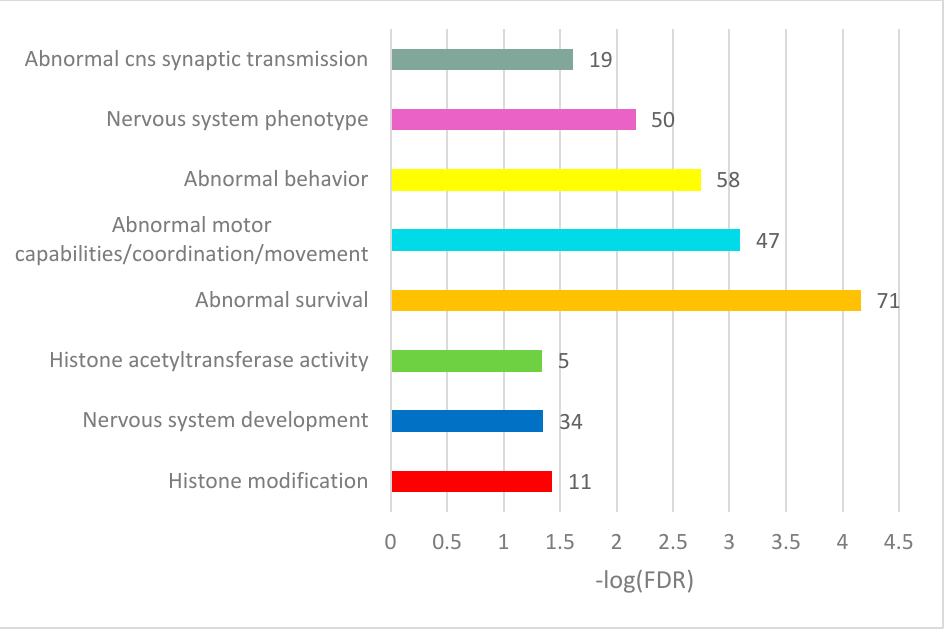
Figure 5. Selected GO annotation terms of 163 merged DAS ES genes (see full GO annotation in Table S2f). The number of the observed DAS ES genes is shown as bar